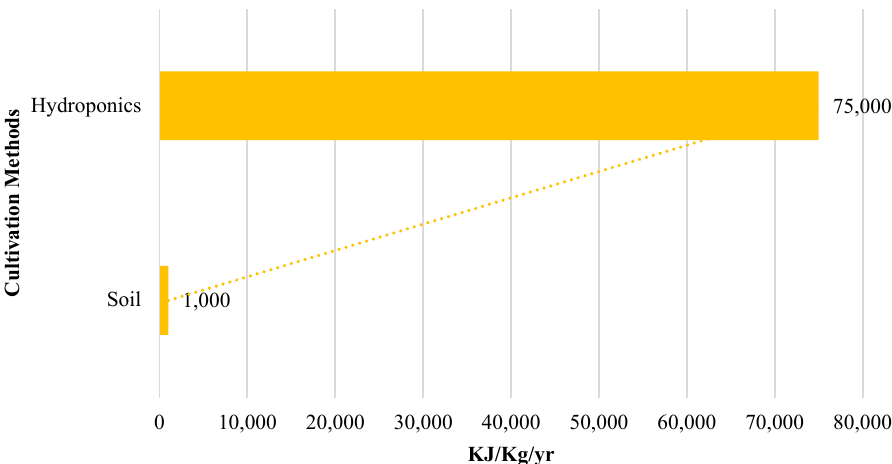
Figure 18. Comparison of energy consumption [KJ/Kg/yr] in the substrate and hydroponic methods of cultivation.